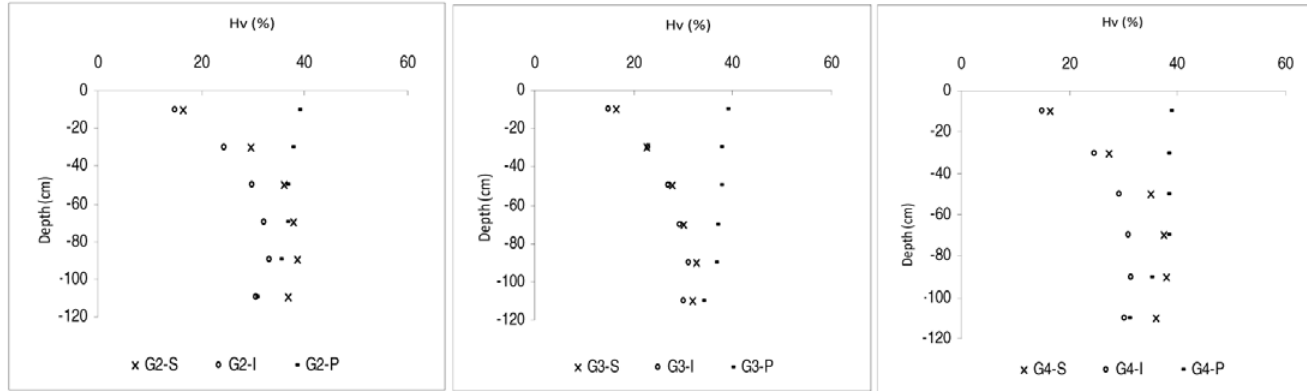
Fig. 11 - Soil water content (%) measured within the second (G distances of 2.0, 2.8 and 4.2 m from trunks, respectively, in May (29-05-2003) after a 20-day-long period of dryness (G 2003) during an irrigation period (G